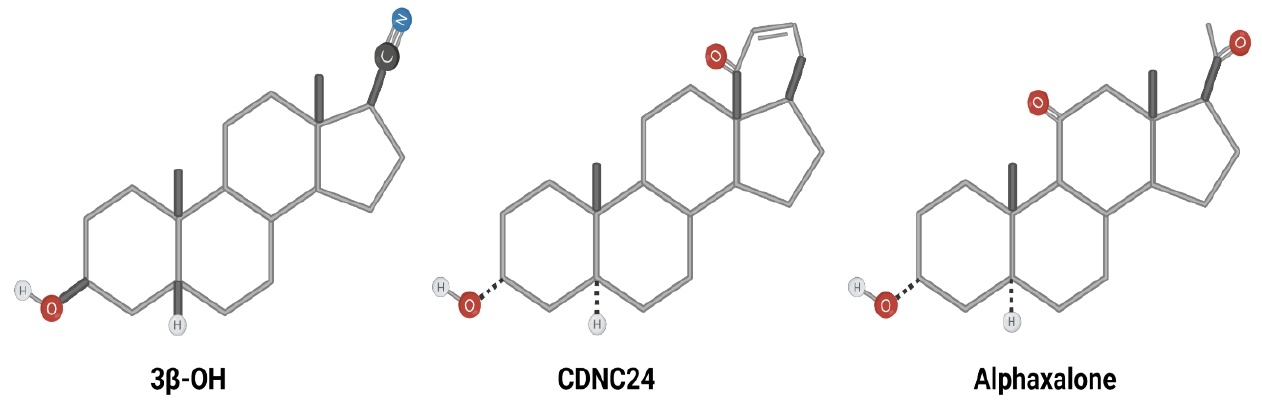
Figure 1. Synthesized neuroactive steroids — chemical structures. Chemical structures of synthe- sized steroids used in our studies: 3β -OH —(3β,5β,17β) -3-hydroxyandrostane-17-carbonitrile; CDNC24 —(3α,5α) -3-hydroxy-13,24-cyclo-18,21-dinorchol-22-en-24-ol; alphaxalone —5α -pregnan- 3α -ol-11,20-dione.